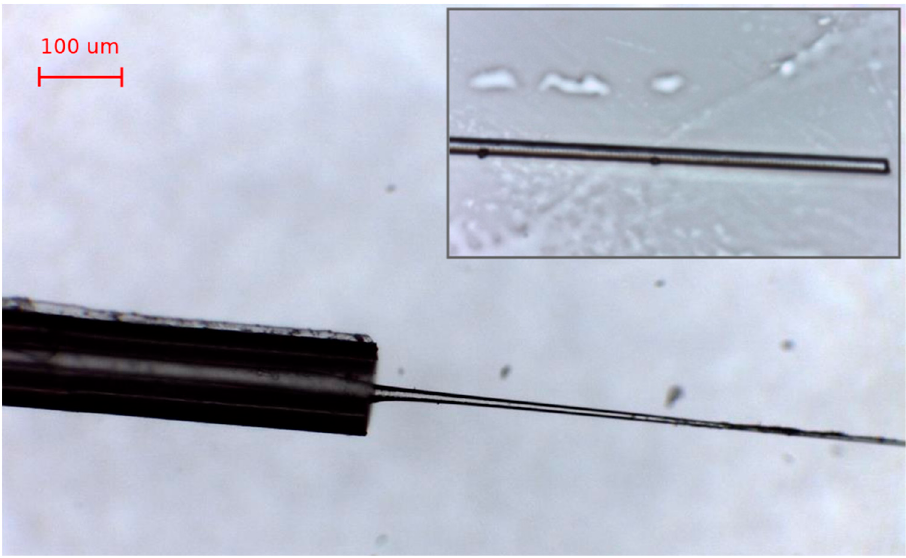
Figure 5. Microscope picture of the etched fiber sensor. Inset shows a detail of the sensor tip.